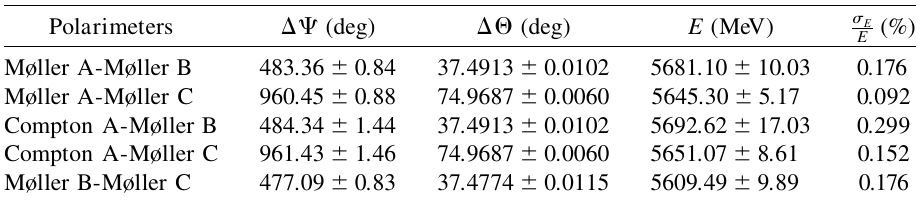
TABLE XI. Summary of energy measurement results comparing only end-station polar- imeters by the relative spin precession method.